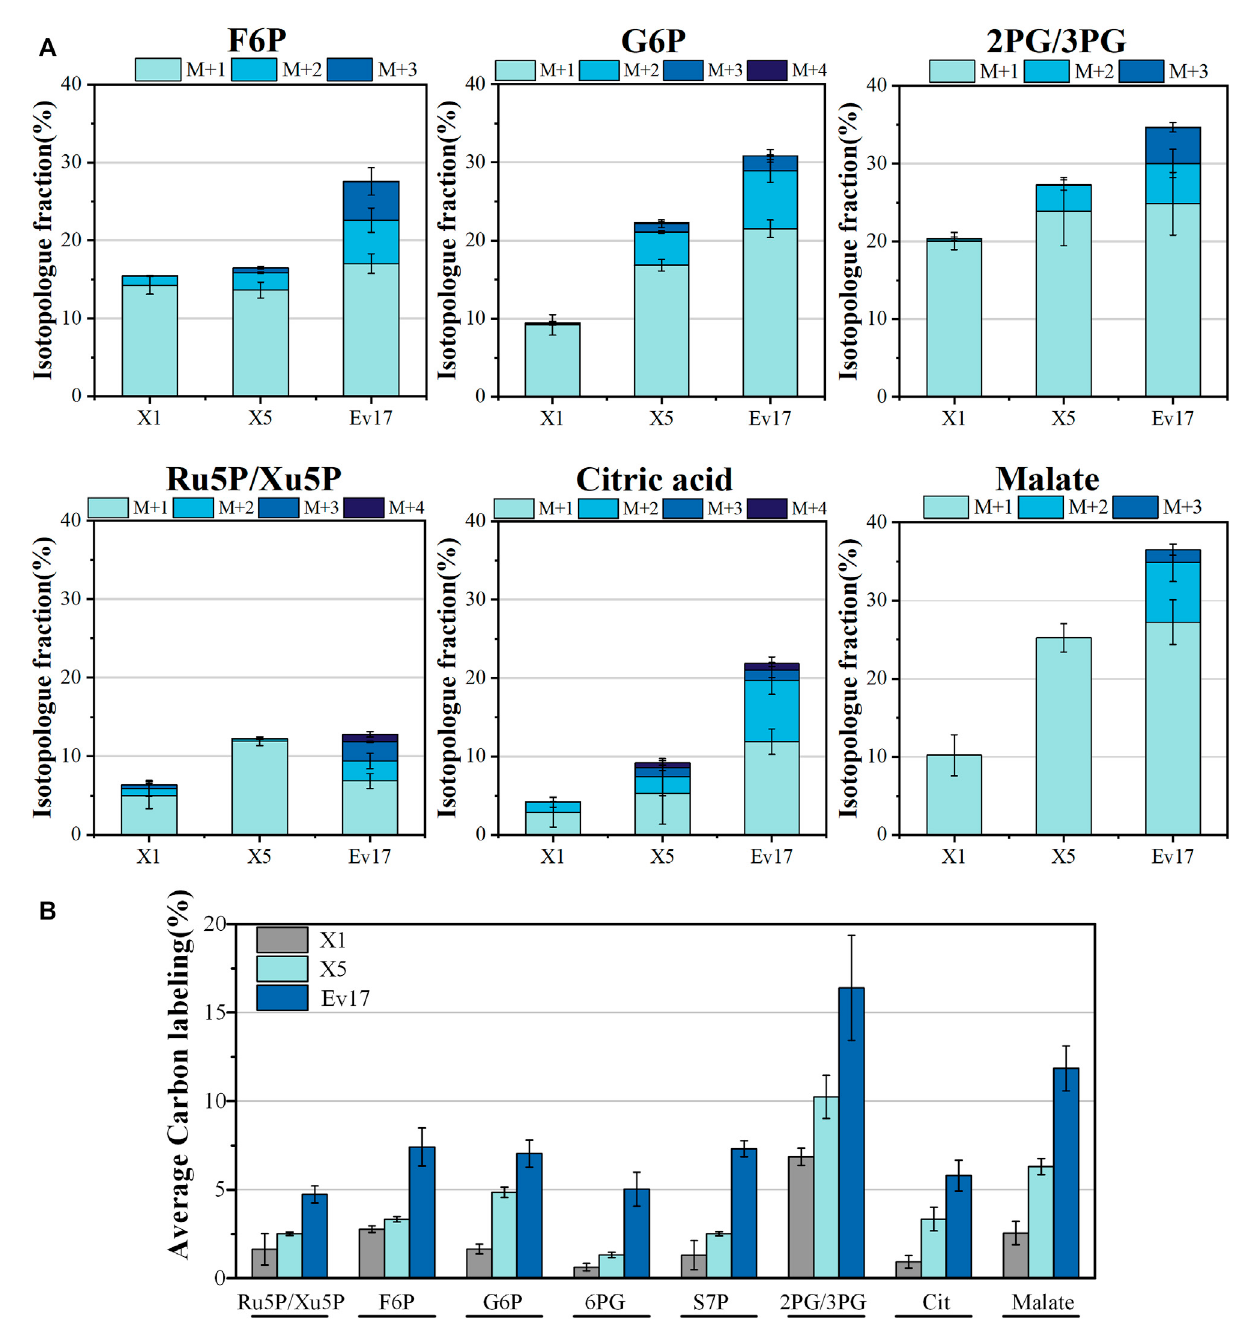
Isotopologuefraction(% 13 C) (A) andaveragecarbonlabeling ofintracellularmetabolites (B) instrainX1,X5,Ev17.Errorbarsrepresentstandarddeviation, n =2.Abbreviations:F6P:fructose-6-phosphate;G6P:glucose-6-phosphate;2/3PG:glycerate-3-phosphate/glycerate-2-phosphate;Ru5P/Xu5P:ribulose- 5-phosphate/xylulose 5-phosphate; 6PG: 6-phosphogluconate; S7P: sedoheptulose-7-phosphate; Cit: